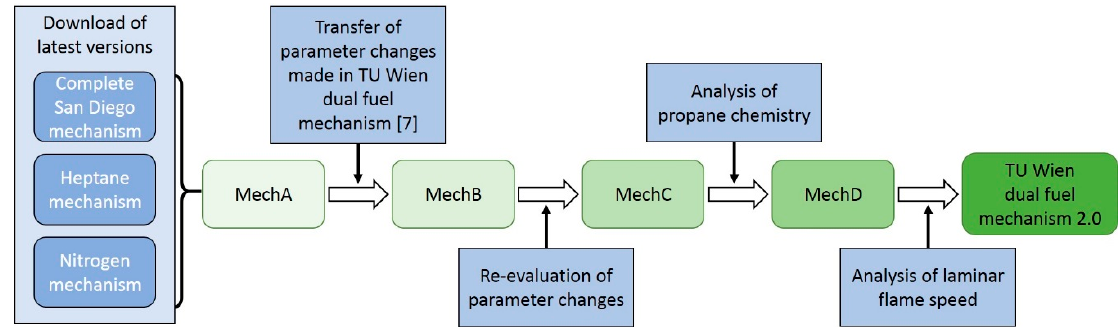
Figure 2. Schematic representation of the mechanism development process presented in the actual study.